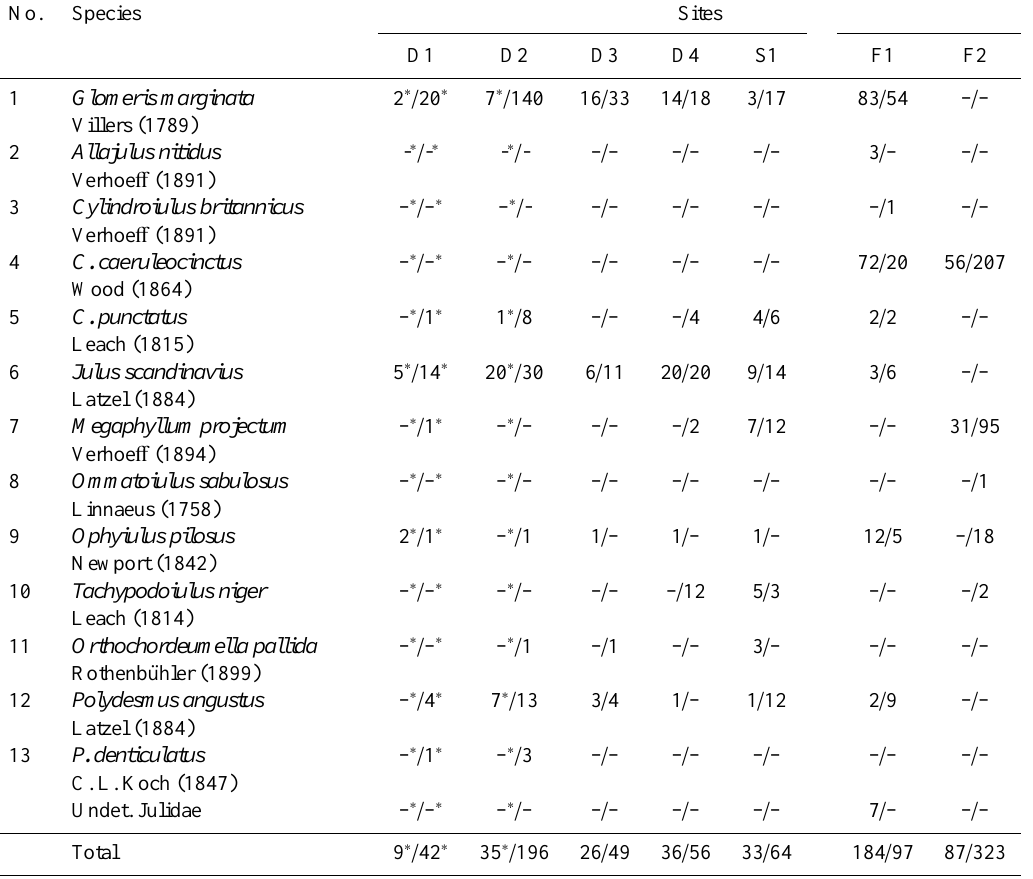
Table 3. Number of Diplopoda individuals by species in coniferous forest habitats (D and S sites) and on fallow ground (F sites): 2009 / 2010. No.